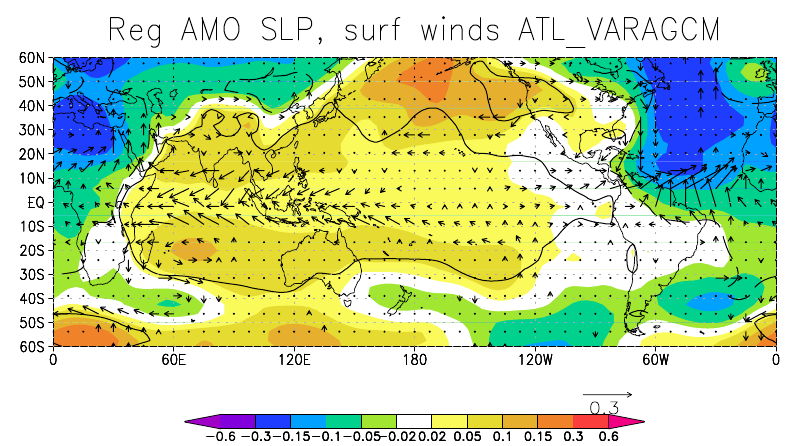
Figure 13. Regression of ATL_VARAGCM SLP and low-level winds onto the AMO index. SLP anomalies that are 95% statistically significant are indicated by contours, and only statistically significant wind vector components are shown. Units are hPa for SLP and m/s for winds.